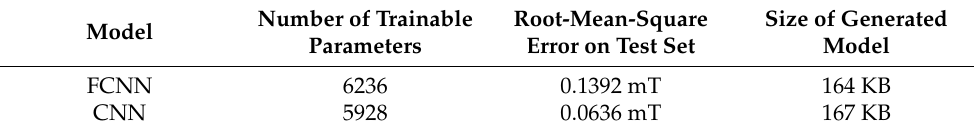
Table 1. Comparison between the fully connected and the convolutional neural network in terms of the number of trainable parameters, the root-mean-square error on the test set after training and the size of the generated model. Number of Model